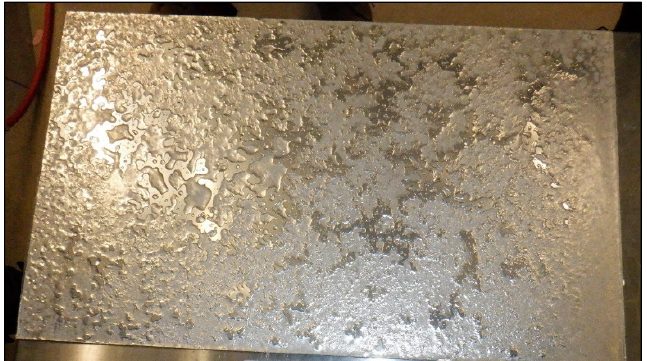
Figure 4. High-intensity freezing rain over aluminum reference plate.